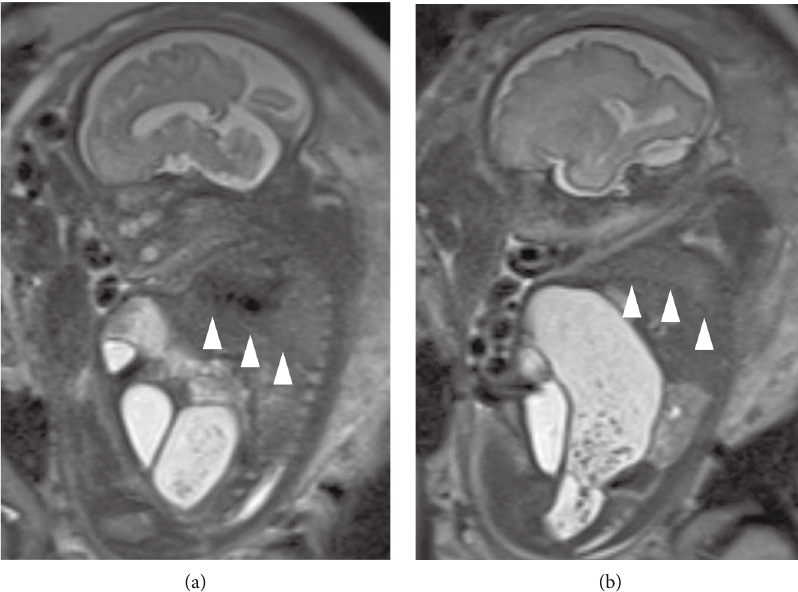
Figure 2: Fetal MRI. Fetal T2-weighted magnetic resonance imaging at 30 weeks showing small lungs with bowel dilation and oligohydramnios. The arrowheads indicate the